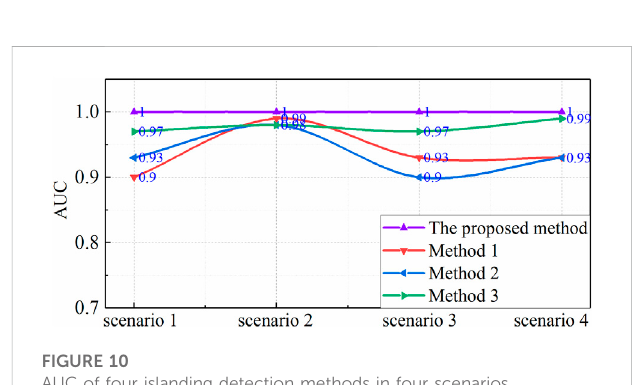
FIGURE 10 AUC of four islanding detection methods in four scenarios